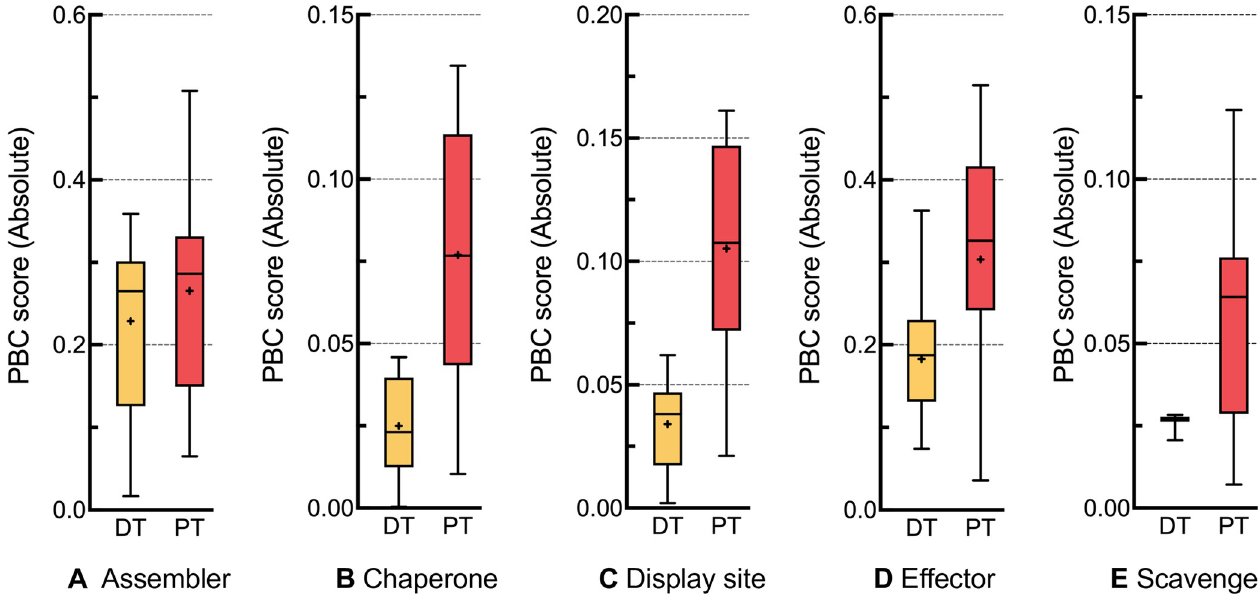
Fig 7. Absolute PBC score distributions on five functions. DT represents the PCLM models directly trained with molecular functional data, and PT represents the PCLM models pre-trained with disordered proteins. https://doi.org/10.1371/journal.pcbi.1010668.g007 Table 2. The predictive performance of DMFpred for five categories of molecular functions on TEST-1 independent test set. Function AUC Sn Assembler